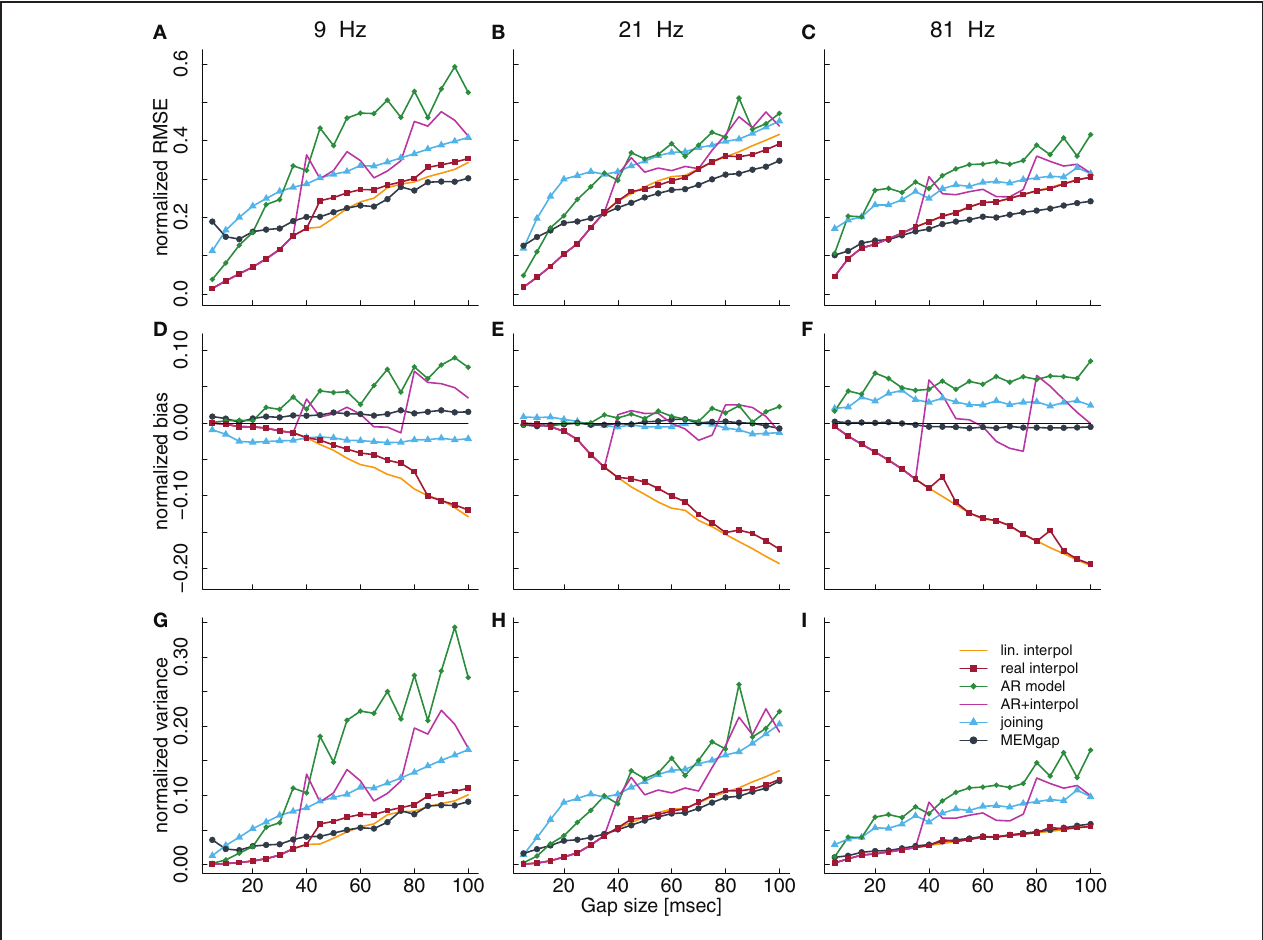
FIGURE 3 | Normalized RMSE, bias, and variance of the spectral power estimation for the frequency bin at 9Hz (A,D,G), 21Hz (B,E,H), and 81Hz (C,F,I) for a model order of 32. The colored lines illustrate the course of the